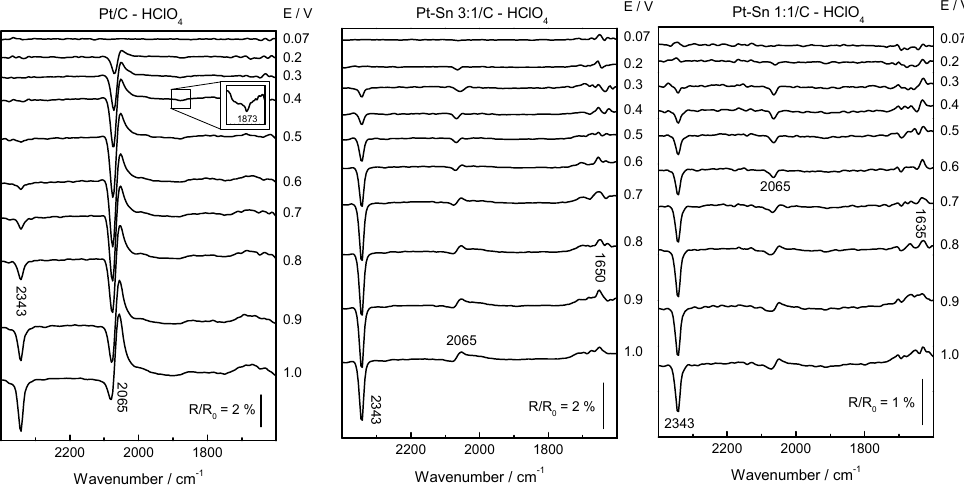
Figure 2. In situ Fourier transform infrared spectroscopy (FTIR) spectra recorded during a CO ad monolayer electrooxidation on Pt/C, Pt–Sn 3:1/C and Pt–Sn 1:1/C catalysts in 0.1 M HClO 4 at room temperature. E ad = R 0 = 0.07 V.